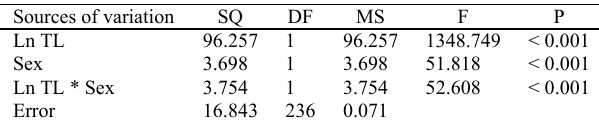
Table 2. Covariance analysis of weight (dependent variable) and total length (TL) (covariate) of males and females of Cynopoecilus melanotaenia from wetlands between São Gonçalo channel and Pelotas stream, during May and June 2005, and September 2006. Ln = Natural Sources of variation